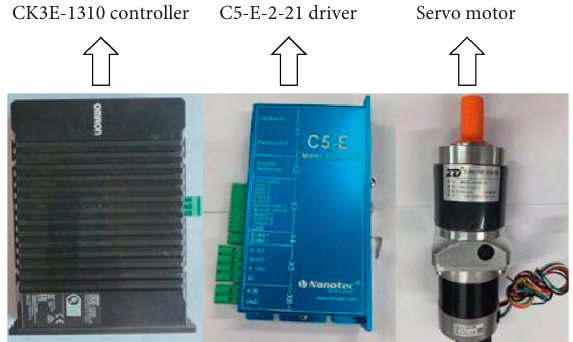
Figure 20: Control and drive system.